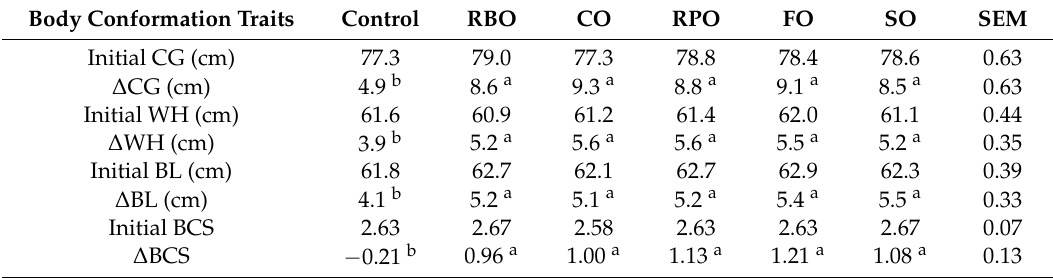
Table 3. Changes in body conformation traits of prime lambs fed various PUFA enriched pellets *. Body Conformation